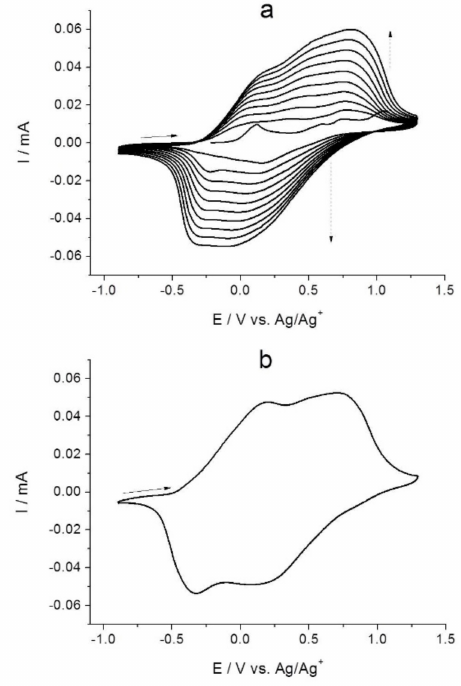
Figure 5. Cyclic voltammograms of a glassy carbon electrode (0.07 cm 2 ) in 0.05 M Et 4 NBF 4 /DCE at a scan rate of 0.05 V s − 1 showing: ( a ) the anodic polymerization of 0.001 mol L − 1 [NiAmben], and ( b ) the electrochemical response of the poly-[NiAmben] film. Table 1. The efficiency of [NiAmben] electropolymerization ( Q redox / Q poly ) at a glassy carbon